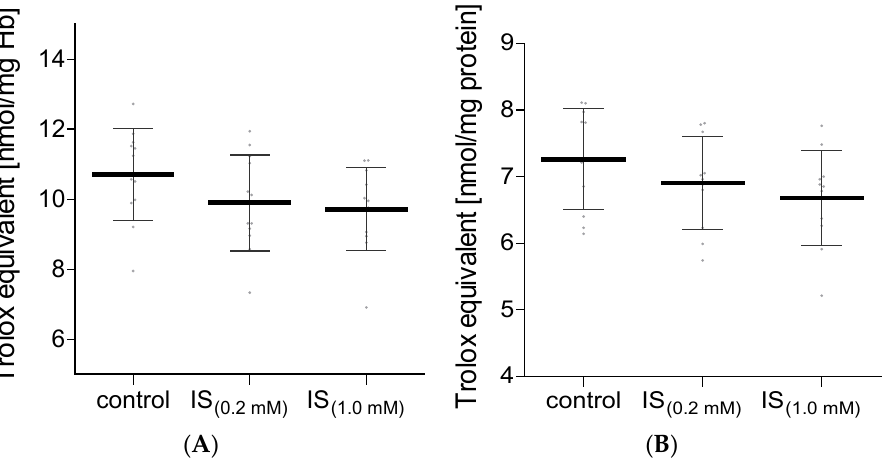
Figure 5. The levels of NEAC in hemolysate ( A ) and plasma ( B ) after incubation with IS, measured using DPPH. Data are expressed as mean ± standard deviation, n = 11. Gray spots: values of single results.